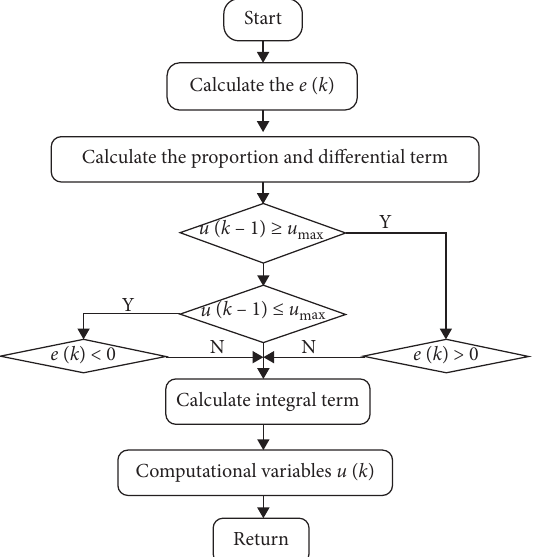
Figure 2: Block diagram of unsaturated integration algorithm.